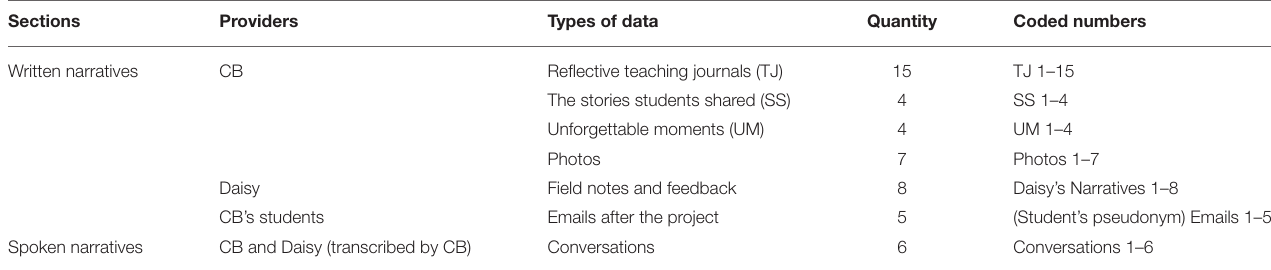
TABLE 1 | Information of collected